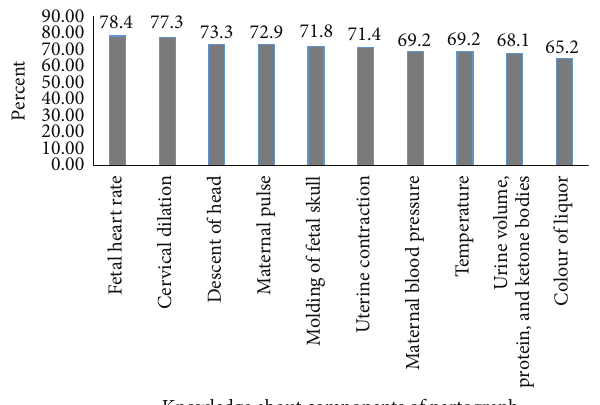
Table 5: Attitude of obstetric caregivers on partograph and its